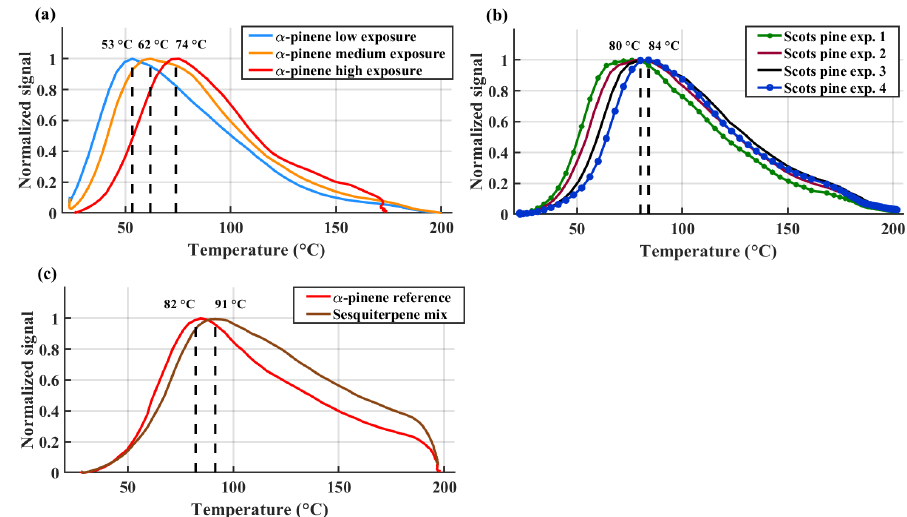
Figure 5. Normalized sum thermograms (all observed ions containing C, H and O atoms) from (a) α -pinene experiments, (b) Scots pine experiments 1–4 and (c) sesquiterpene mixture experiment together with reference α -pinene experiment. T max values of the sum thermograms are shown with dashed lines. In panel (b) only the T max values of Scots pine experiment 1 and Scots pine experiment 4 are shown for